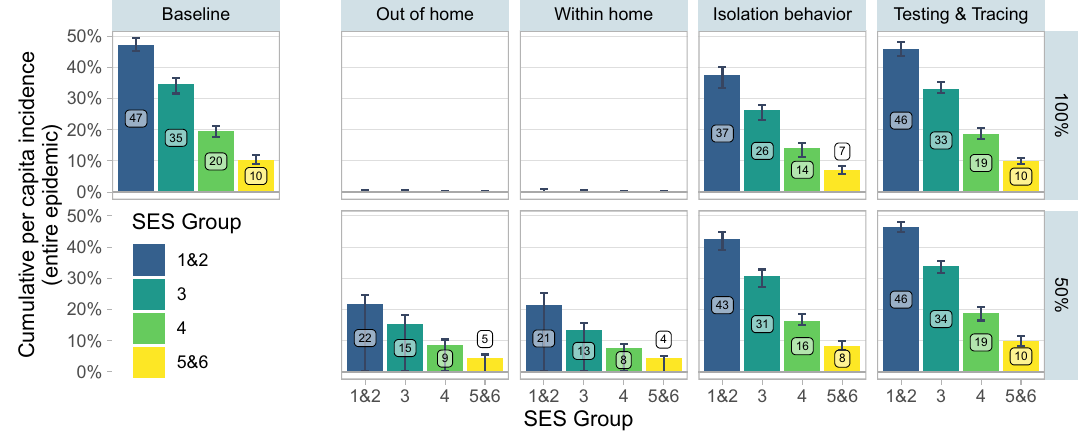
Figure 3. Upward Adjustment Scenarios. Baseline indicates the model with the parameters of Table 1 and no adjustment. The panels in columns 2 to 6 are the results of upward adjustment scenarios. In the top row of columns 2 to 6 (100% adjustment), the set of parameters indicated in the column heading is adjusted so that all SES have the same value as SES 5&6. In the bottom row (50% adjustment), all SES other than 5&6 have their parameters adjusted to move halfway to the value of 5&6. Parameters adjusted in each set are as follows: out of home (number of contacts outside the home), within home (within-household SAR, household size), isolation behavior (probability of isolating conditional on observing symptoms, testing positive, being contact traced, and probability of quarantining as a household), testing & tracing (probability of self testing, delay in test consultation, delay in test results, and probability of being contact traced). Point estimates denote the median of 50 simulations. Error bars indicate the 0.025 and 0.975 quantiles of the 50 simulations. When the error bars are close to 0, this indicates that some simulated epidemics die out in the very early stages, leading to incidence close to 0.